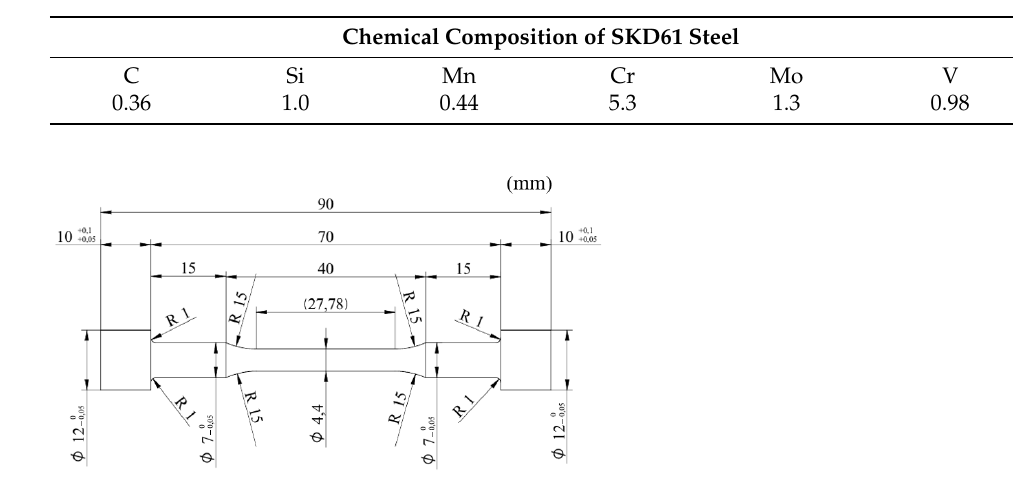
Figure 9. Configuration of the specimen.